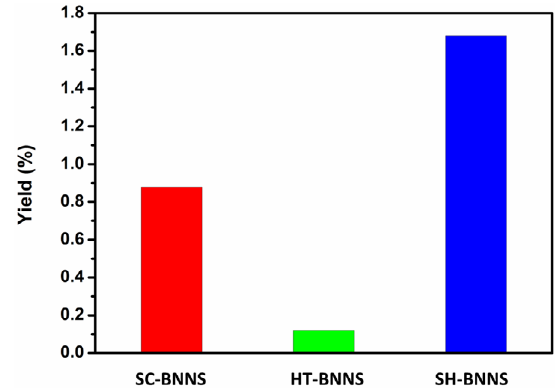
Fig . 8 Yields of different